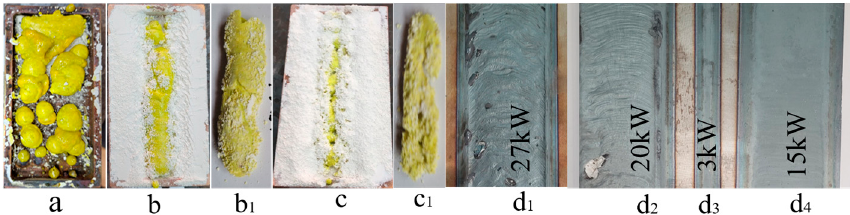
Figure Figure 1. Photographs of YAG:Ce samples synthesized in the mode with scanning (( a ), P = 20 kW/cm 2 ), without scanning (( b , c ) P = 5 and 4 kW/cm 2 )), in crucibles ( a – c ), taken out from crucibles ( b 1 , c 1 ), and traces of impact of beams with P = 27(7), 20(5), 3, 15(4) kW/cm 2 on steel plate ( d ). On figure ( d 3 ) shows the structure of the beam distribution on the surface of the sample.